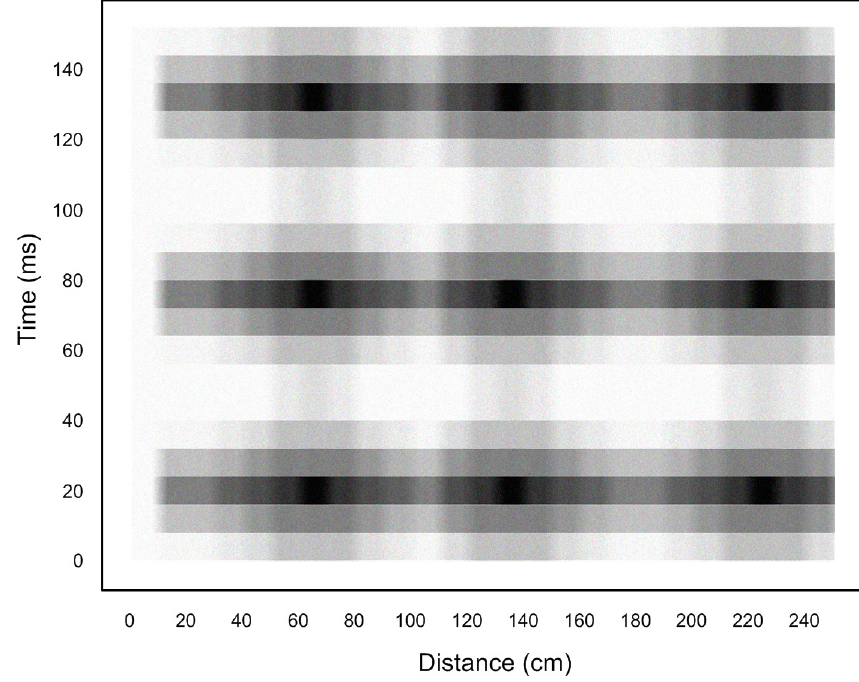
Figure 10. Time–distance data plot. Frequency = 7.8